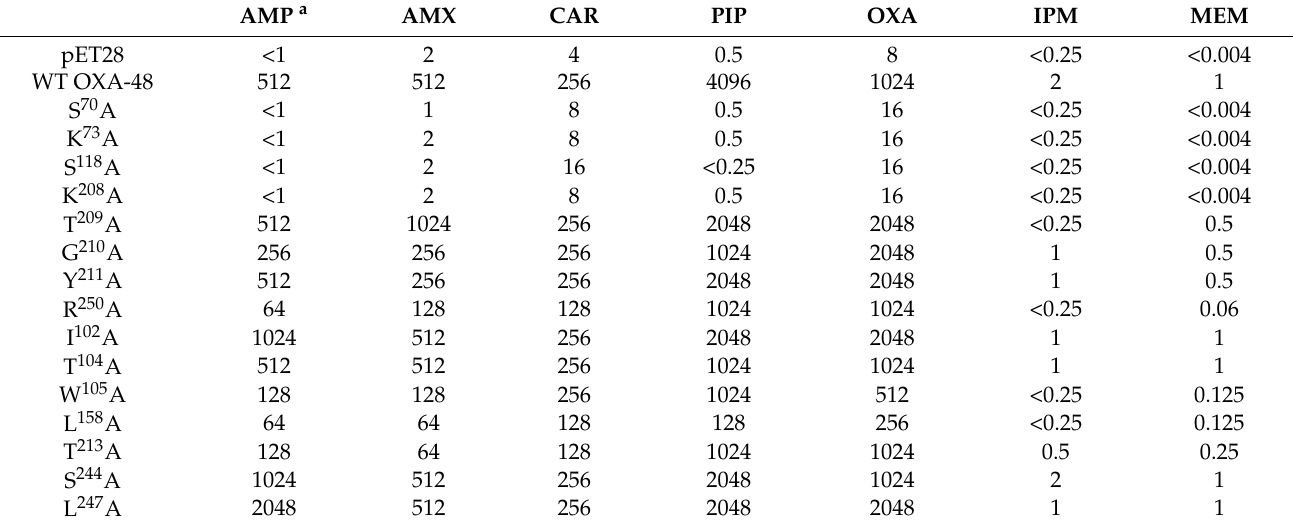
Table 1. MICs of OXA-48 constructs and variants towards different β -lactams.